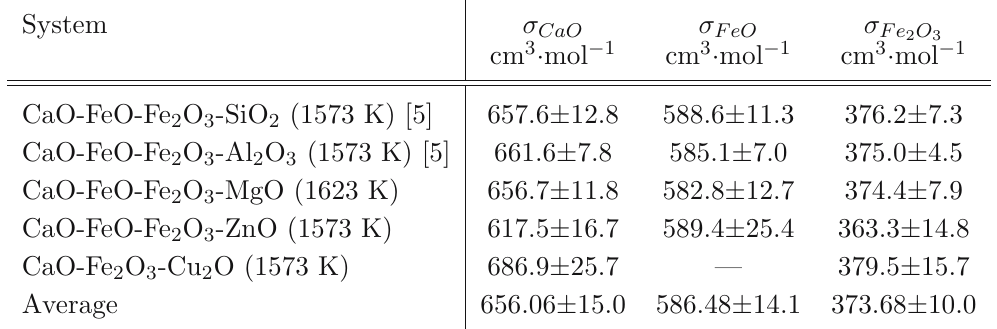
Table 8 Surface tension of pure oxides calculated from individual independent